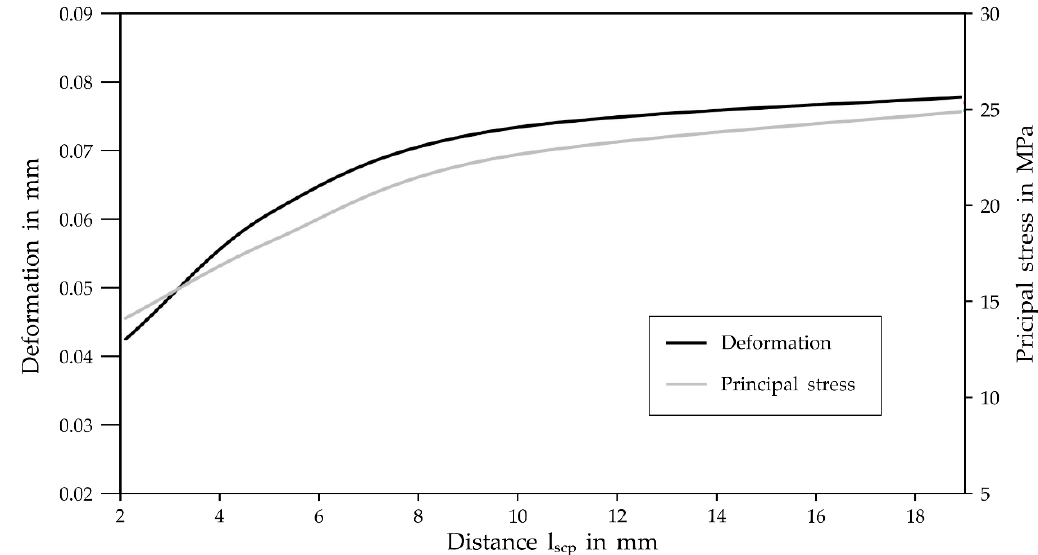
Figure 12. Change in stress and strain for different passive cell spacings.